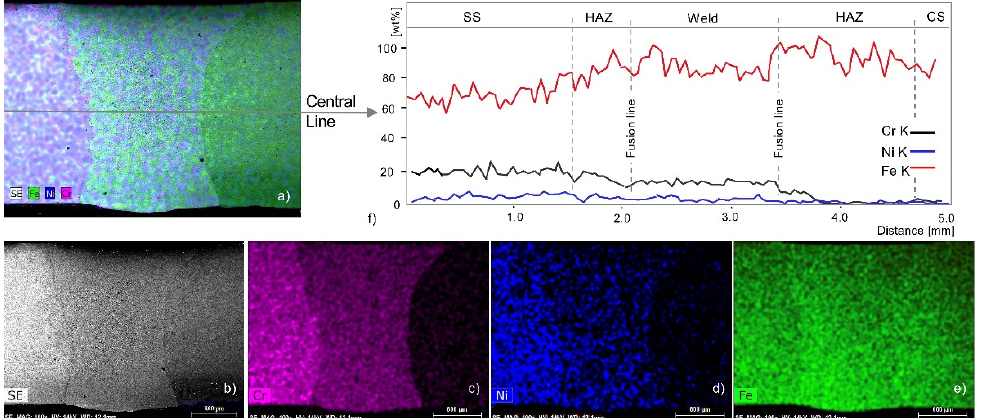
Figure 5. EDX mapping and line analysis of the CS–SS laser-welded joint: ( a ) overall mapping of Cr, Ni, and Fe; ( b ) SEM image; ( c ) Cr map; ( d ) Ni map; ( e ) Fe map; ( f ) central line scan analysis of Cr, Ni, and Fe.